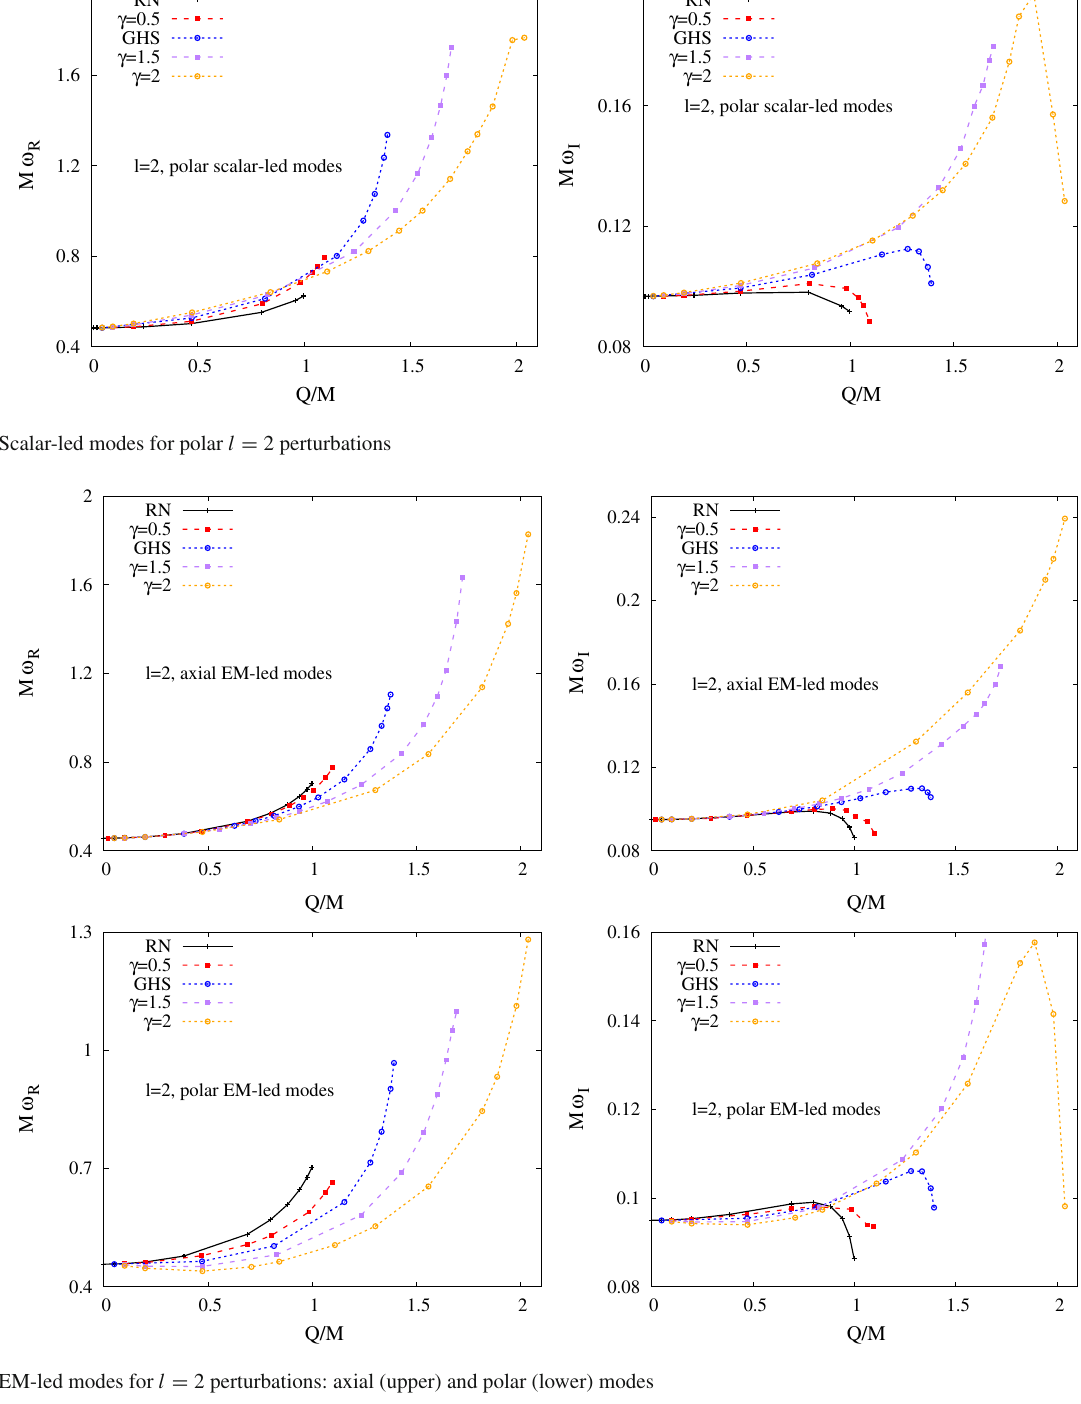
Fig. 6 EM-led modes for l = 2 perturbations: axial (upper) and polar (lower)